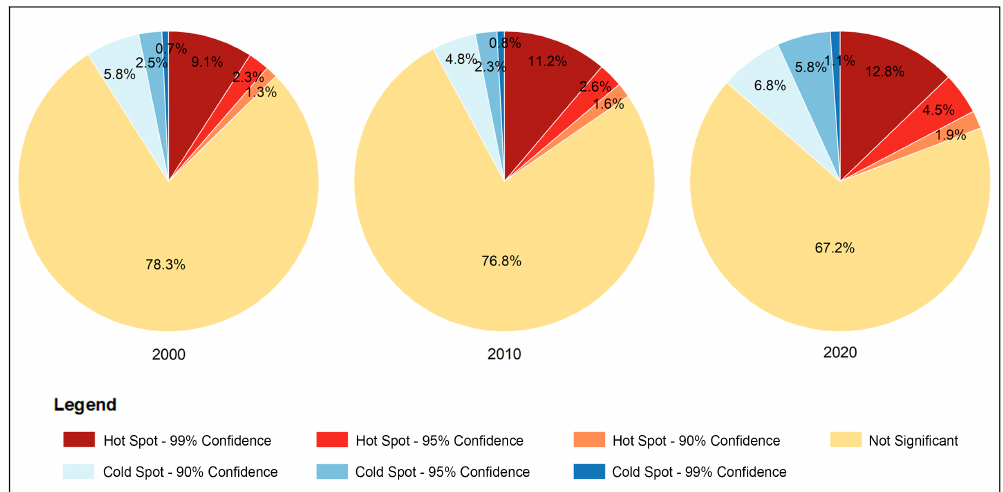
Figure 6. Statistics on the percentage of hot and cold spots in the study area.